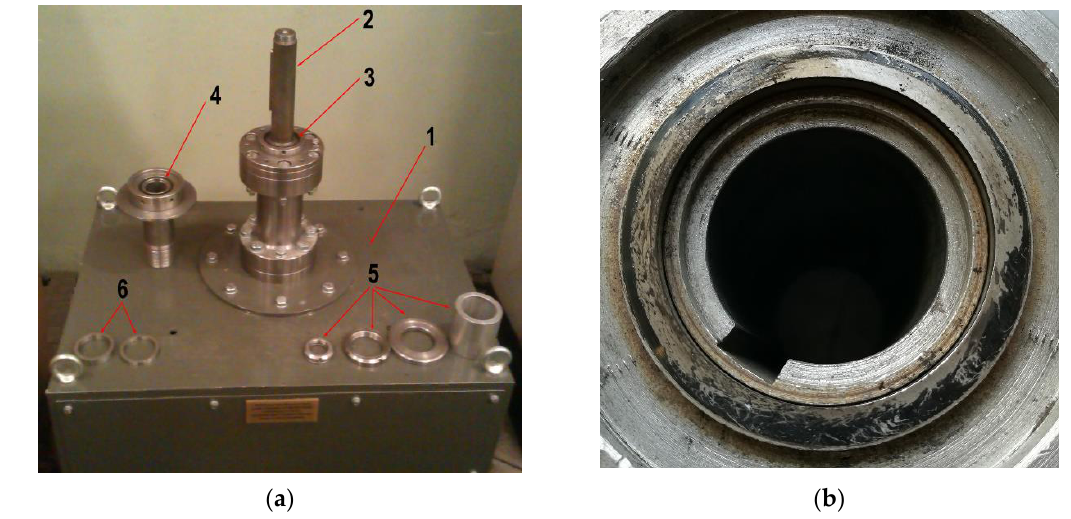
Figure 3. View of the test stand, ( a )—components, ( b )—testing head with the sample after the test with coal abrasive. 1—test stand body with a motor, 2—driving shaft, 3—upper sample handle, 4—bottom sample handle, 5—fixing components, 6—tested samples.